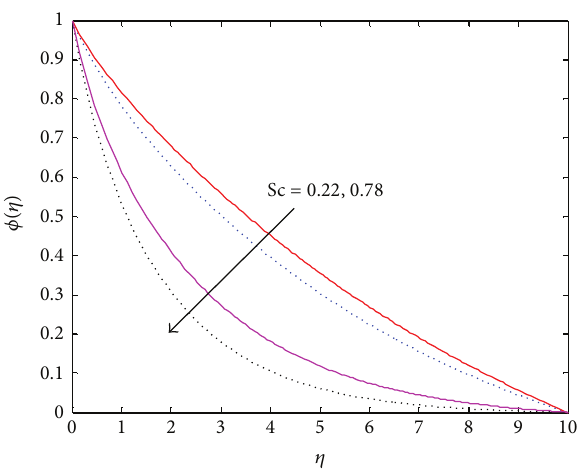
Figure 8: Concentration distribution for Sc and 𝐾 𝑝 .